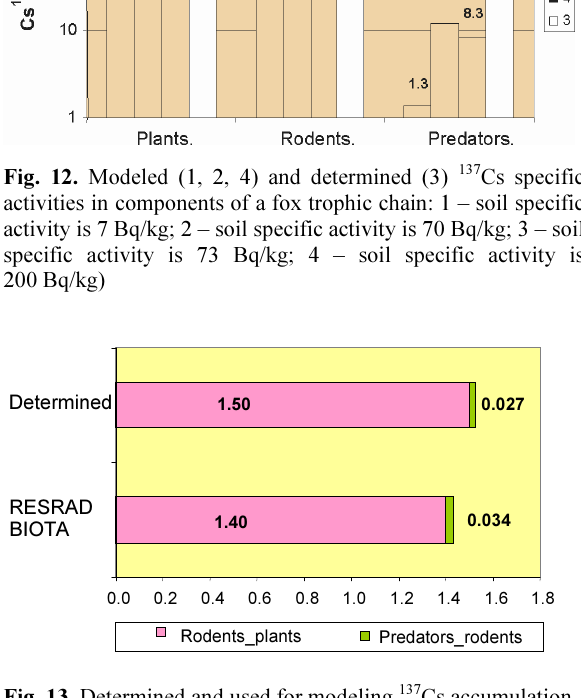
Fig. 13. Determined and used for modeling coefficients in components of fox trophic chain